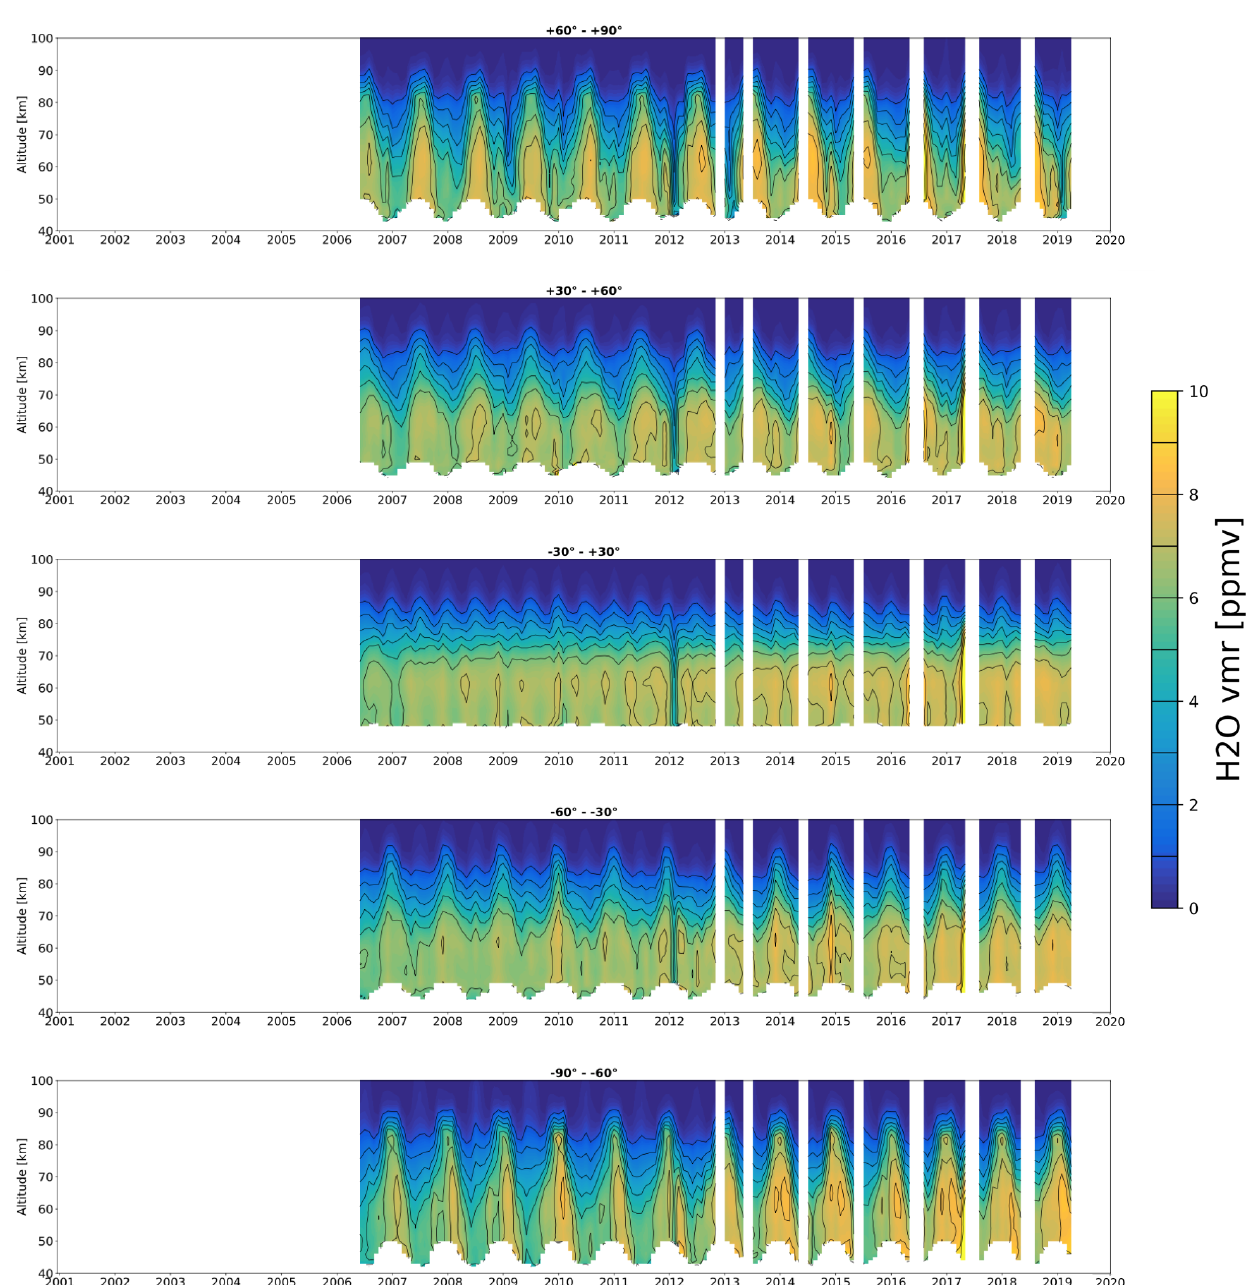
Figure A1. Time series of FM13 H 2 O volume mixing ratios measured by SMR for different latitude bands. The white areas indicate periods and altitudes at which the number of measurements in the given latitude band is lower than 10. The ticks on the x axis correspond to the beginning of each